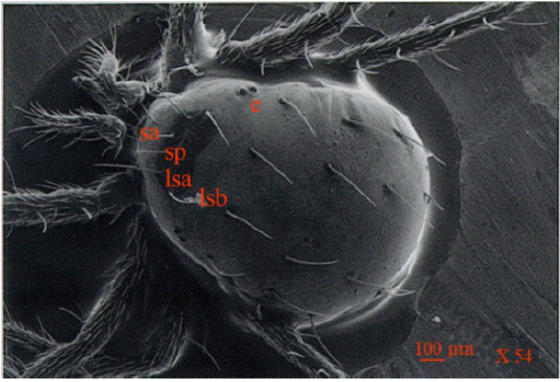
Figure 5. Scanning electron micrograph showing dorsal view of Anystis baccarum . Anterior margin bears a pair of sensilla (sa); prodorsal shield bears two pairs of long setae (lsa + lsb) and a pair of sensilla (sp); two pairs of eyes are located postero-lateral to prodorsal shield (e) (Photo: Andrew G. S. Cuthbertson © ).